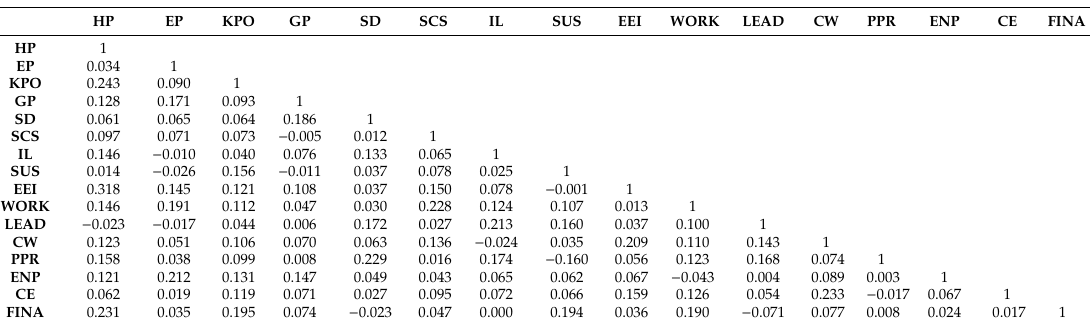
Table 2. Results of discriminant validity.